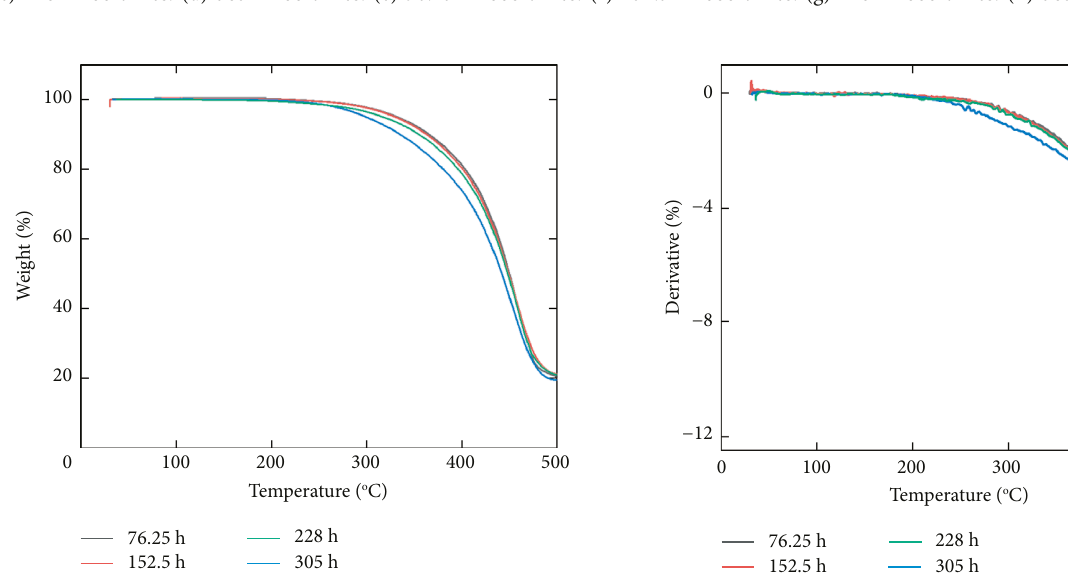
Figure 10: DTG curves of 70# base asphalt under different UV aging